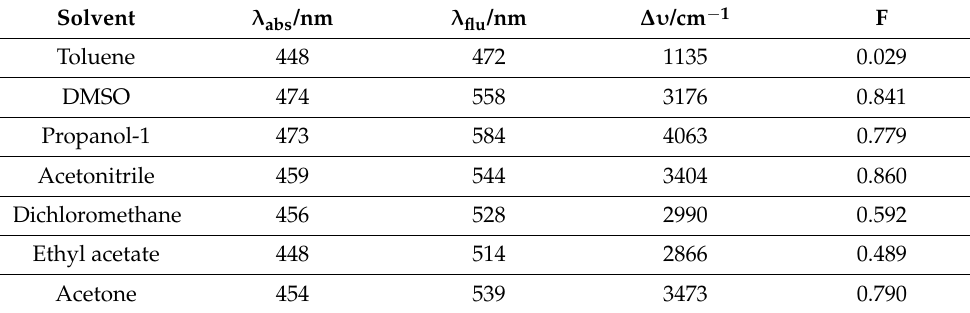
Table 1. Absorption and emission data of 4Met-BAC in different solvents.